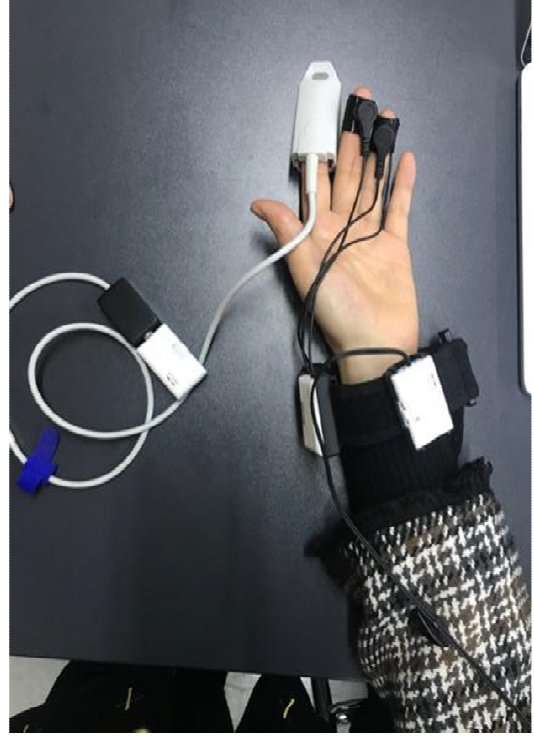
Figure 8. The subject wore wireless physiological sensors.